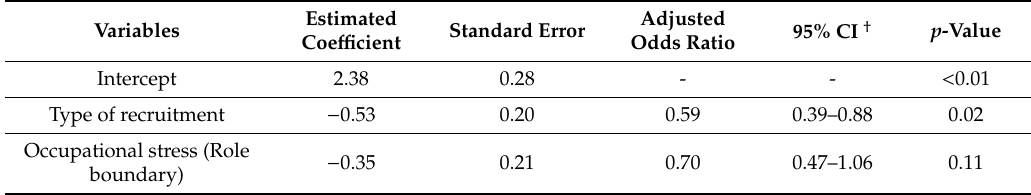
Table 3. Ordinal logistic regression of variables associated with turnover